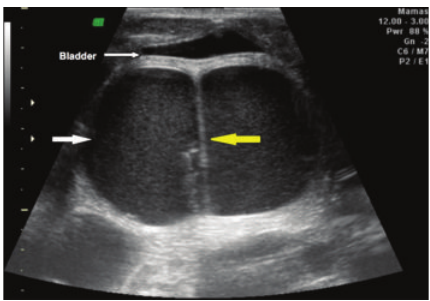
Figure 1: Ultrasound scan in axial plane at the level of the fetal pelvic region, shows the bladder brought forward by the cystic mass of dense content (white arrow), at the midsagittal septum (yellow arrow).